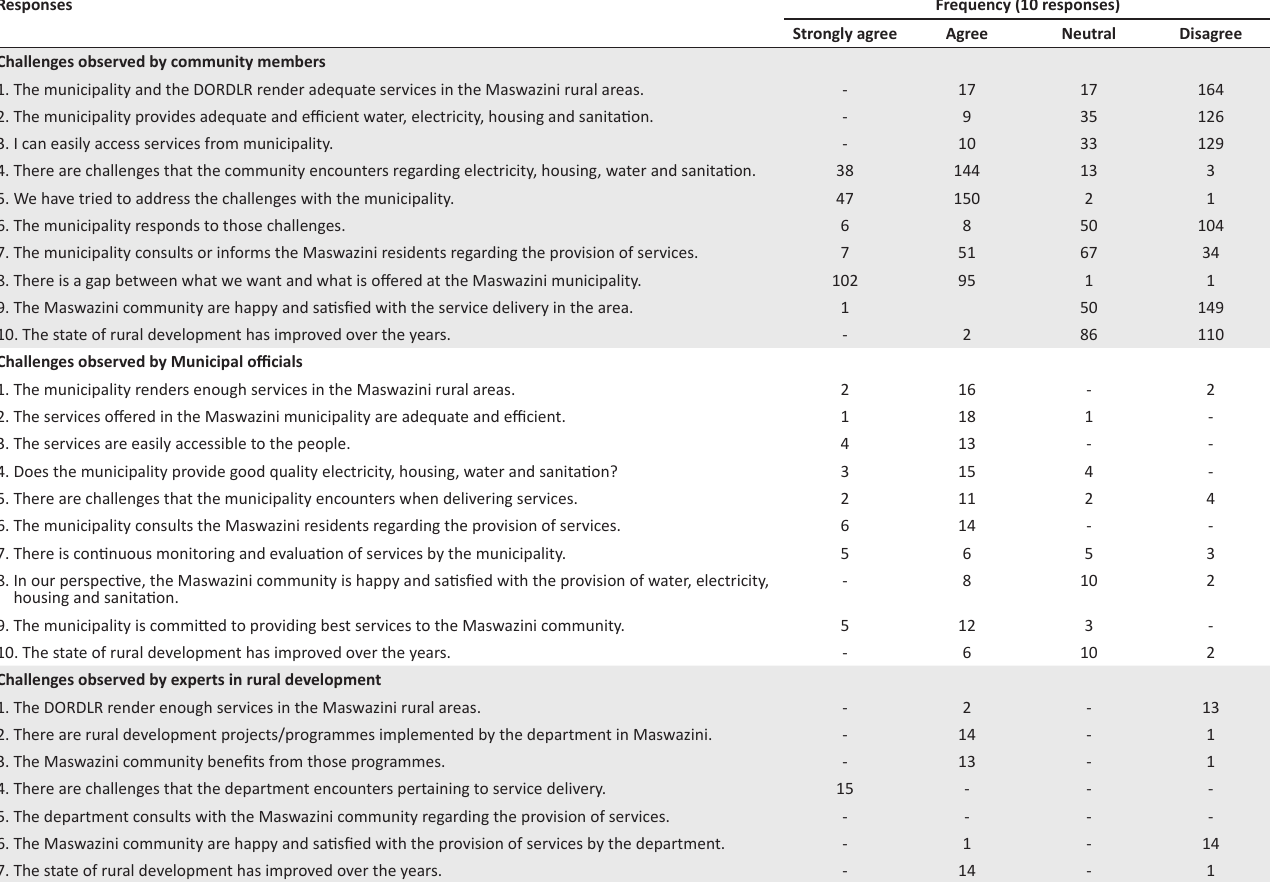
TABLE 5: Responses on service delivery challenges at Okhahlamba Local Municipality.